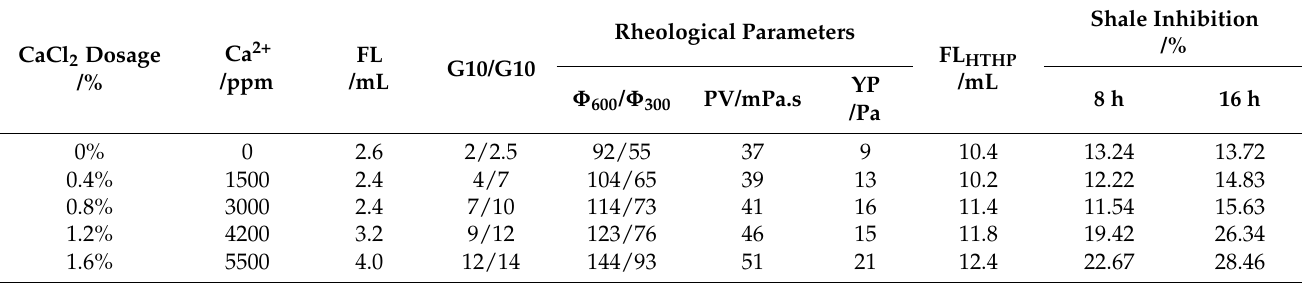
Table 5. Evaluation of calcium resistance.